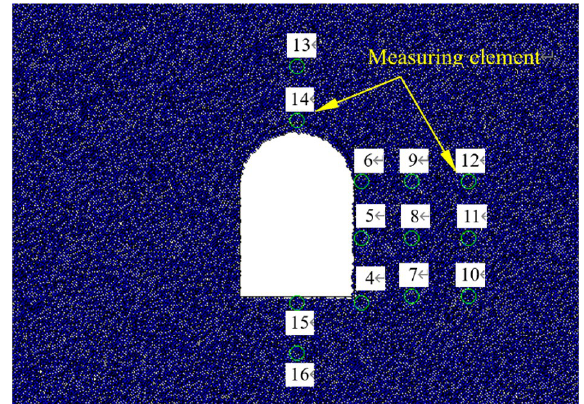
Figure 16. Simulation model.